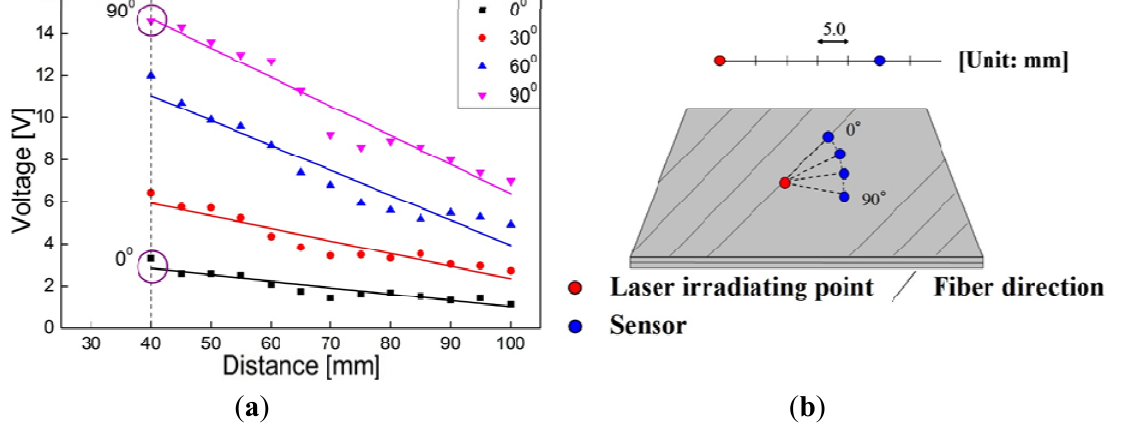
Figure 10. Amplitude of Lamb waves versus propagation distance (5 mm increment) and propagation direction (30° increment) in a CFRP plate: ( a ) relationship between distance of propagation and amplitude (fitted by least squares method of a linear relationship); ( b ) experimental model of the measurement.